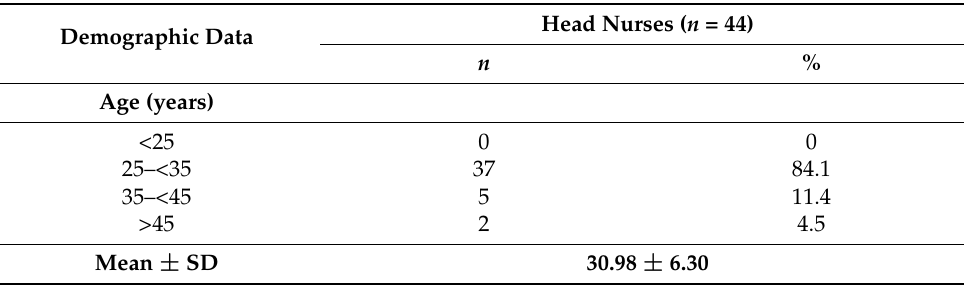
Table 1. Demographic data of studied head nurses ( n =